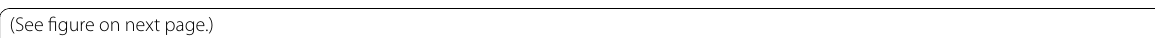
figure on next Fig. 8 Calcareous nannofossils from the Marnes de la Russille (Barremian) of the Swiss Jura Mountains and from the Aptian of the section Angles (SE‑France). All LM pictures from La Sarraz–Les Buis quarry (without sample numbers: LSBMRu1) and Eclépens quarry (with sample numbers: EC). LM pictures from Angles section: 16–17 (same specimen in different orientation) and 18–19 (same specimen in different